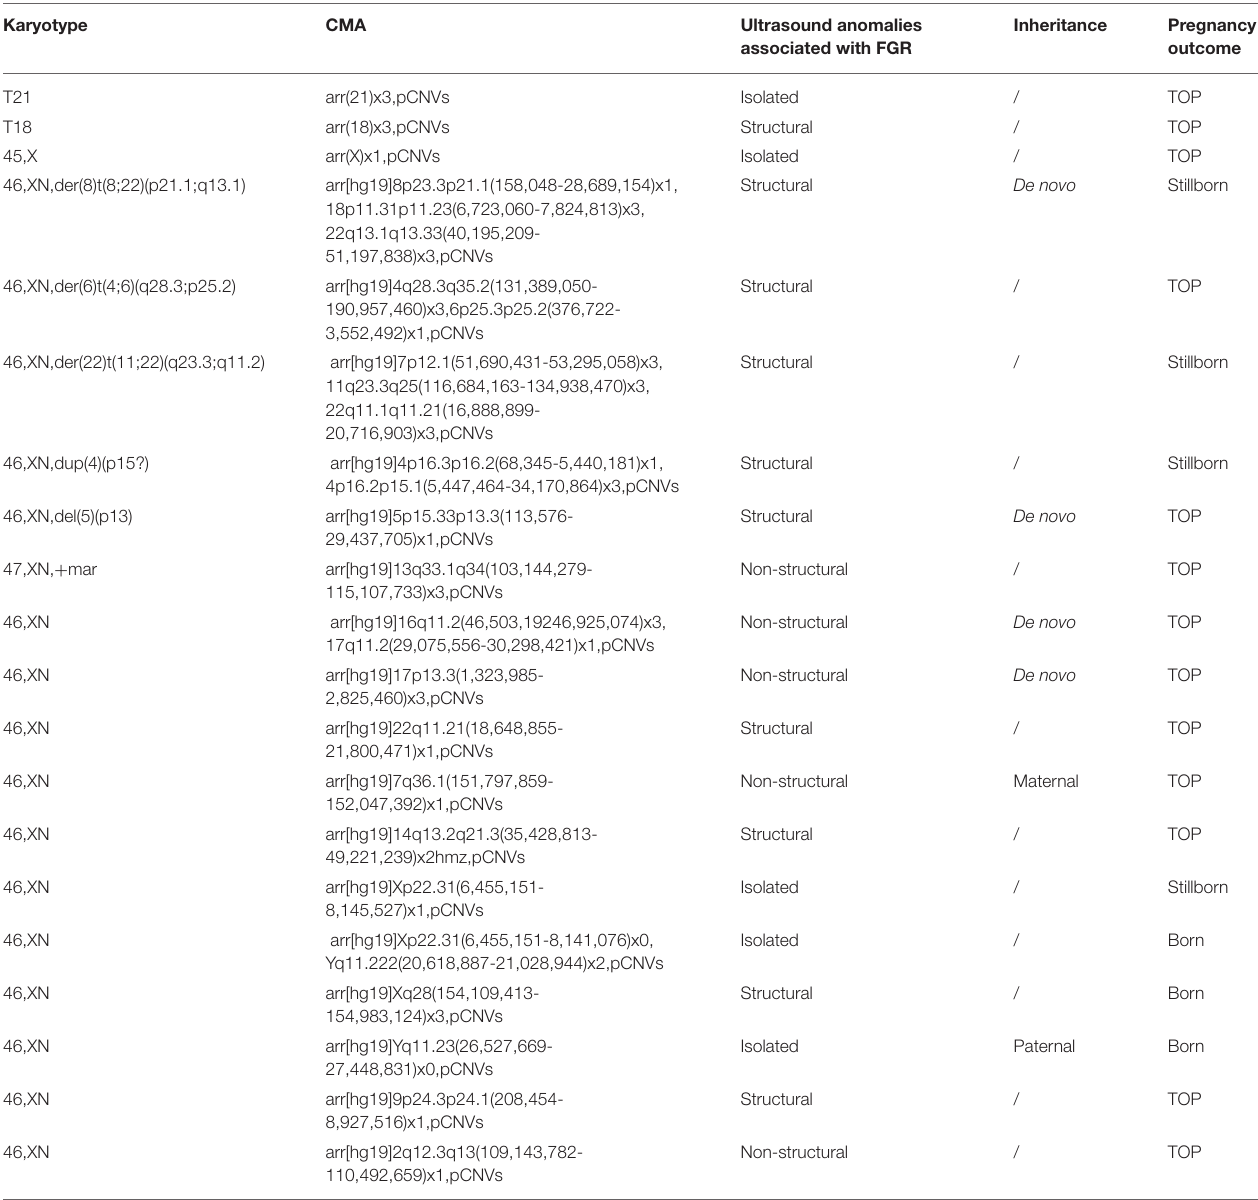
TABLE 1 | Comparison of chromosomal abnormalities detected by karyotyping and CMA. Karyotype CMA Ultrasound anomalies